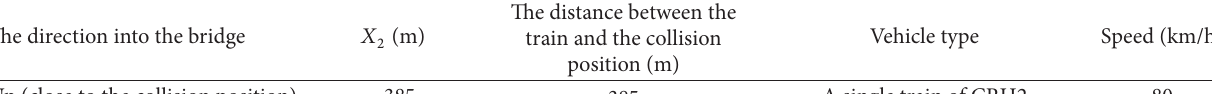
Table 2: Calculation condition of a single car (motor).